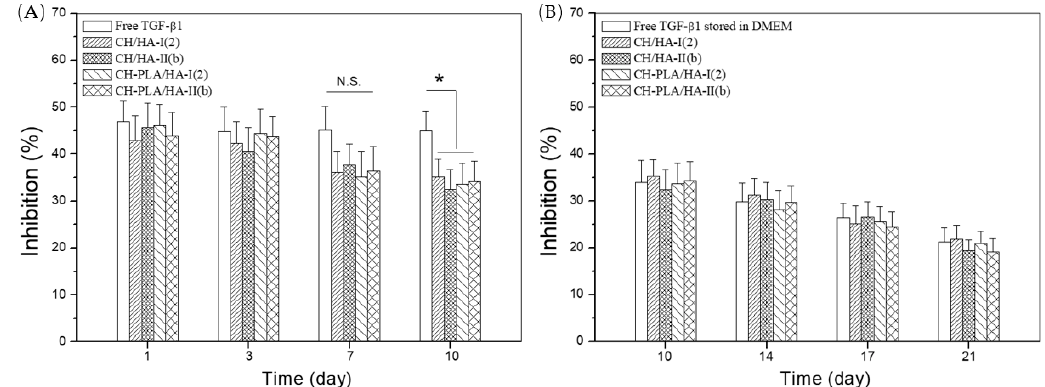
Figure 5. Percent mink lung cell growth inhibition ( A , free TGF- β 1 without storing treatment; and B , free TGF- β 1 stored in DMEM (dulbecco’s modified eagle medium) at 37 °C for different time intervals changing from 10 to 21 days) of TGF- β 1 released from different microspheres during varied periods ( n = 3; N.S. no significance; * p < 0.05).